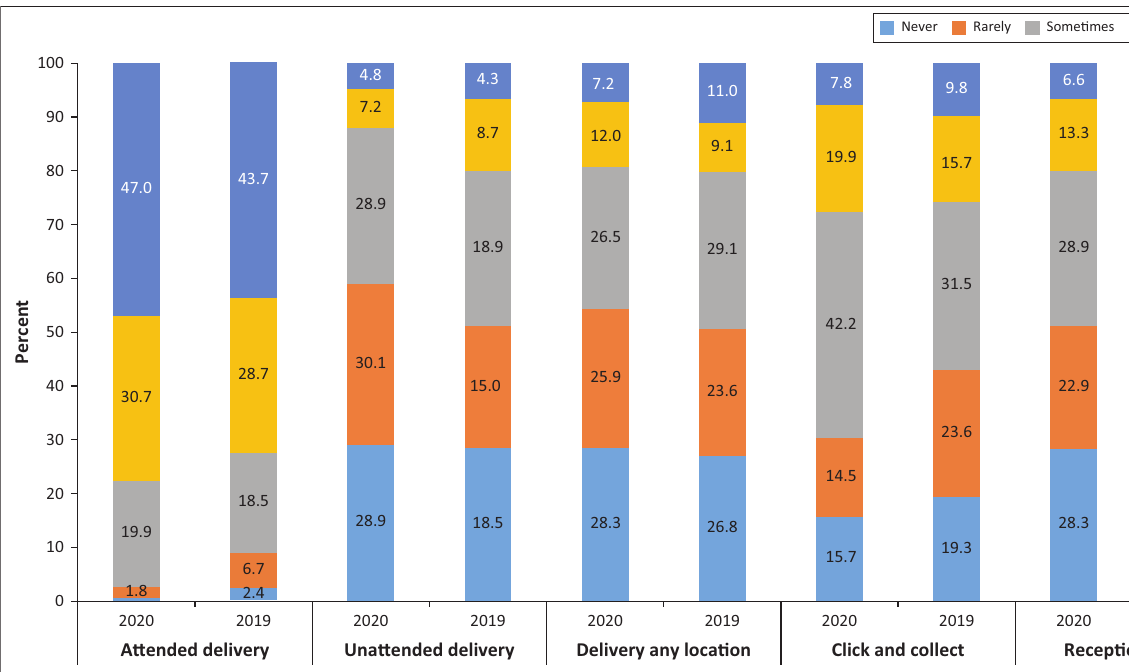
FIGURE 4: Online delivery options.